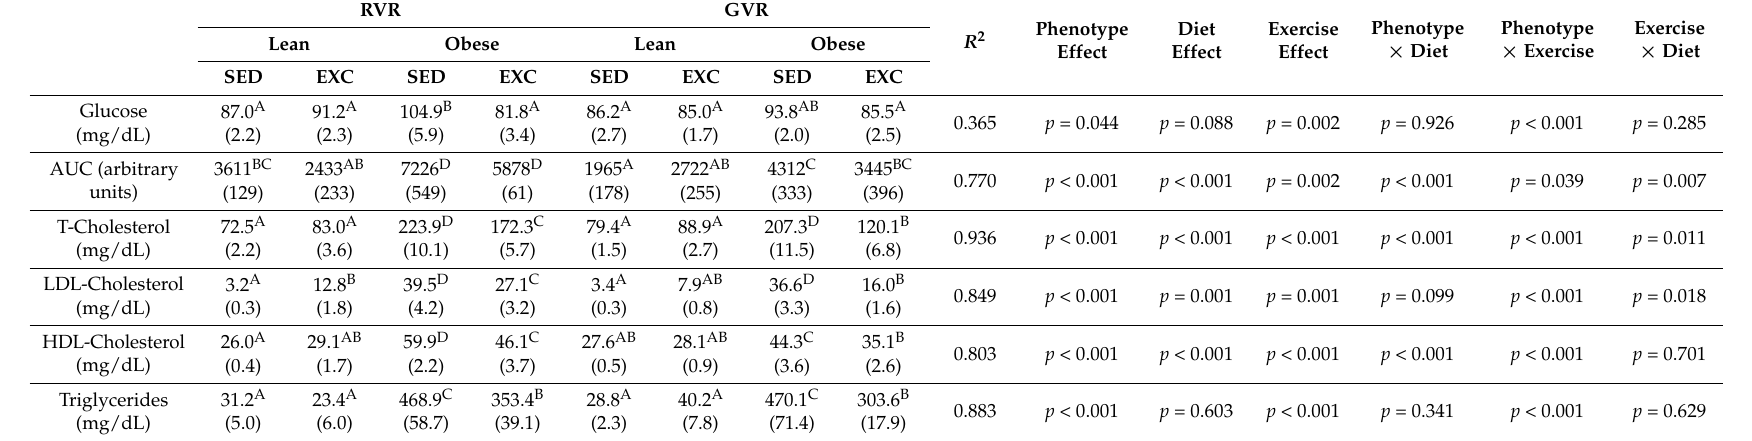
Table 4. Effect of diet, phenotype, and aerobic interval training protocol on blood and plasma parameters related to glucose and lipid metabolism. RVR GVR R